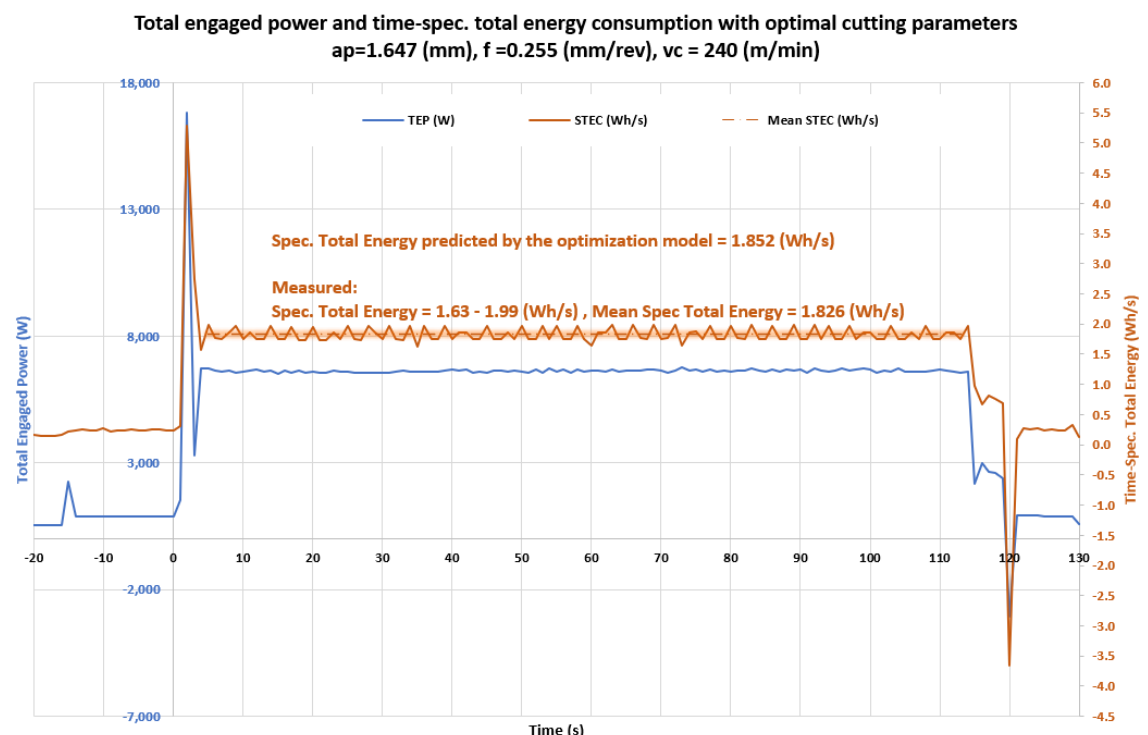
Figure 17. Measurement of the STEC for optimal set of cutting parameters values.